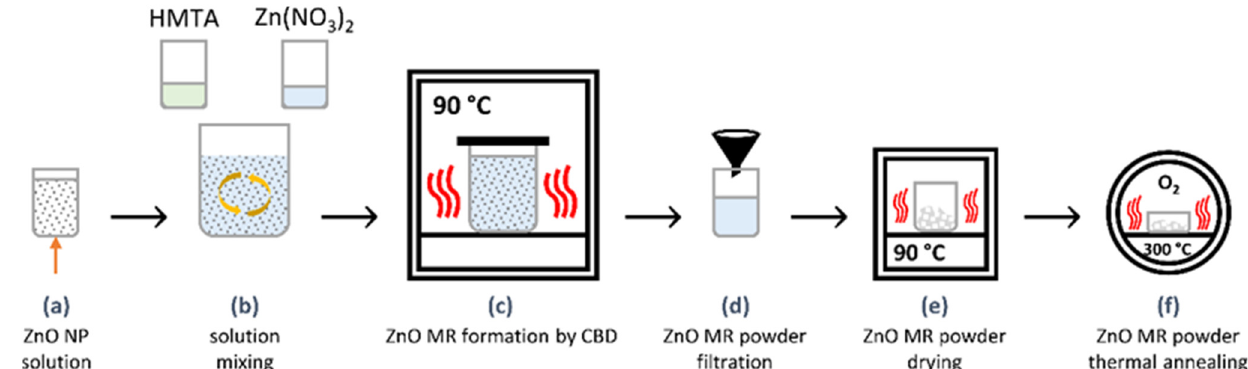
Figure 1. Fabrication steps of ZnO MRs: ( a ) Dispersion of ZnO NPs into deionized water via ultrasonication to form the ZnO NP solution; ( b ) Homogenization and mixing of the dispersed ZnO NP solution with the two precursor solutions to obtain the CBD solution; ( c ) Formation of ZnO MRs by CBD in a sealed reactor kept in an oven; ( d ) Filtration of ZnO MR powder using a nitrocellulose filter; ( e ) Drying of ZnO MR powder in an oven; ( f ) Thermal annealing of ZnO MR powder in a tubular furnace.